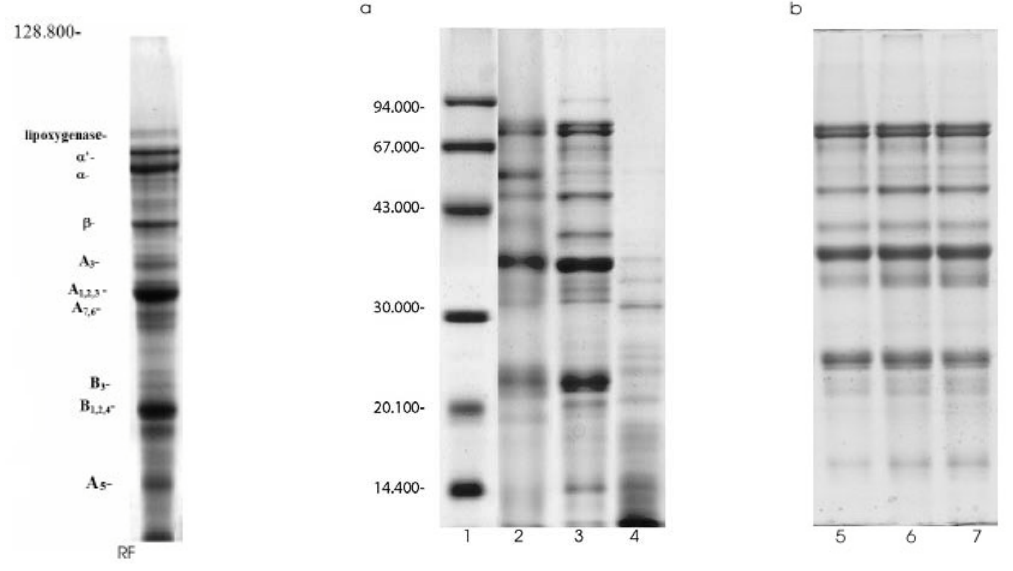
Figure 2. SDS-PAGE analysis of modified traditional concentrates; RF-raw flour, 1.Molecular weight standards, 2.Traditional concentrate, 3. Functional concentrate,4. Pepsin-modified concentrate, 5,6,7 Traditional concentrate modified for 30, 60 and 90 minutes,